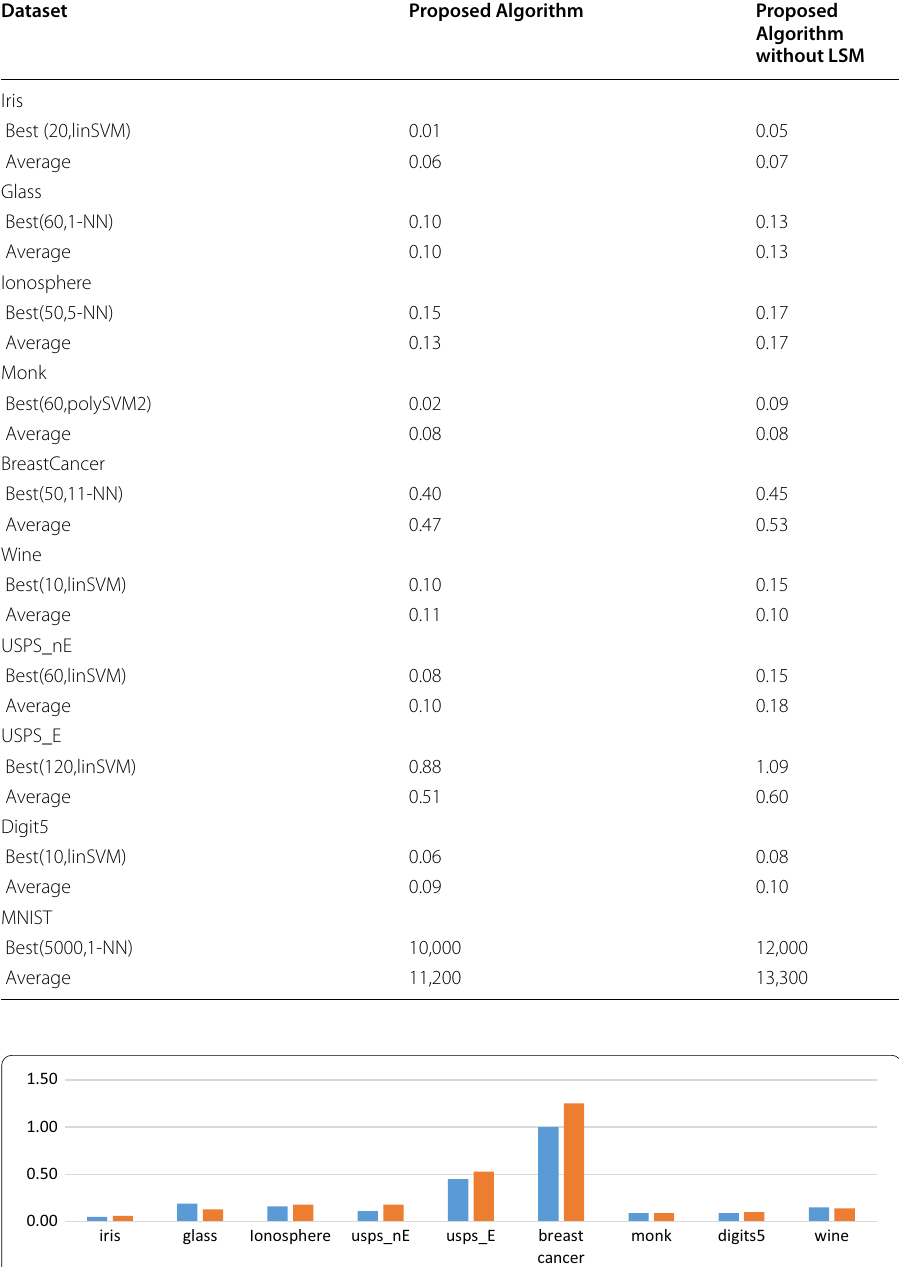
Table 8 Classification runtime of the proposed method with and without LSM Dataset Proposed Algorithm Proposed